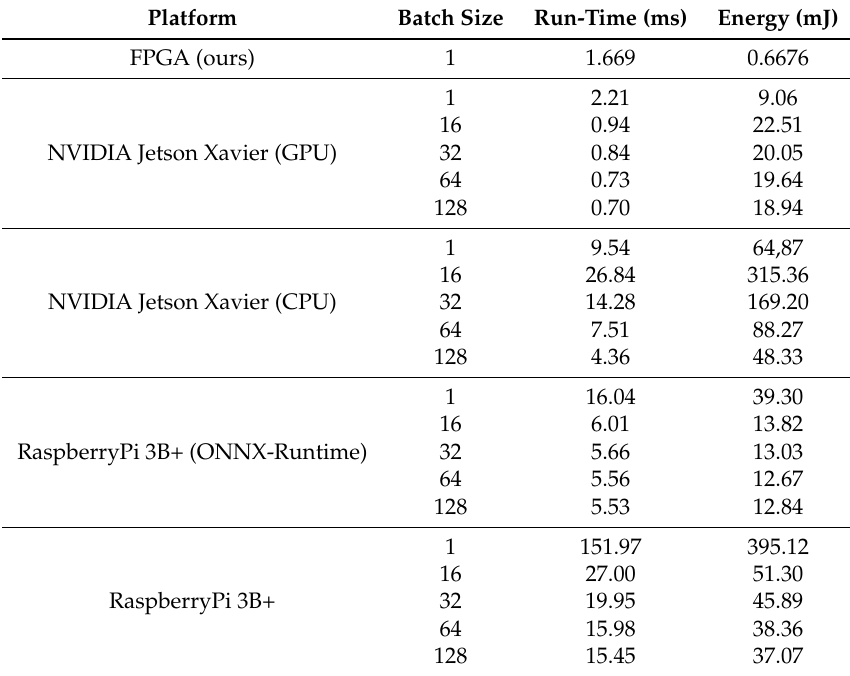
Table 4. FPGA vs. different embedded platforms performance analysis.